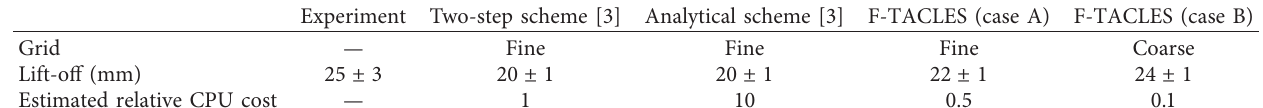
Table 2: Comparison between chemistry modeling strategies.